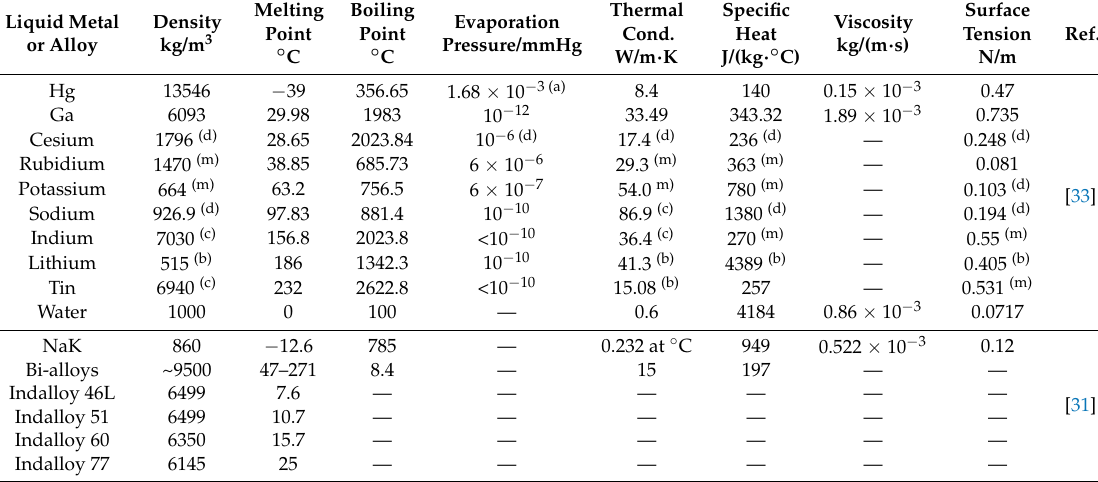
Table 2. Physical properties of some liquid metals and alloys. Note: (a) 25 ◦ C; (b) 200 ◦ C; (c) 160 ◦ C; (d) 100 ◦ C; (n) 50 ◦ C; (m) at melting point. Reproduced with permission from [33]; published by Springer,